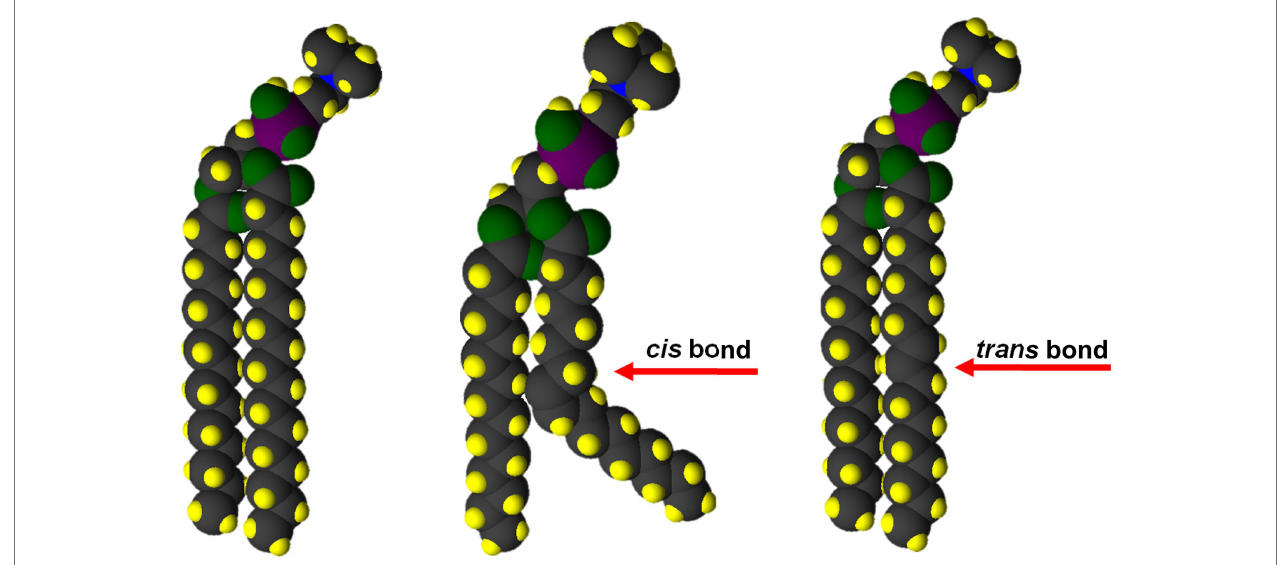
FIGURE 3 | Only cis double bonds provide the membrane fluidity and functionality required for life. The bend in the fatty acid chain caused by a C=C cis double bond (center) disrupts Van der Waals interactions. Both saturated (left) and trans unsaturated (right) fatty acids provide for maximum Van der Waals interaction and a rigid